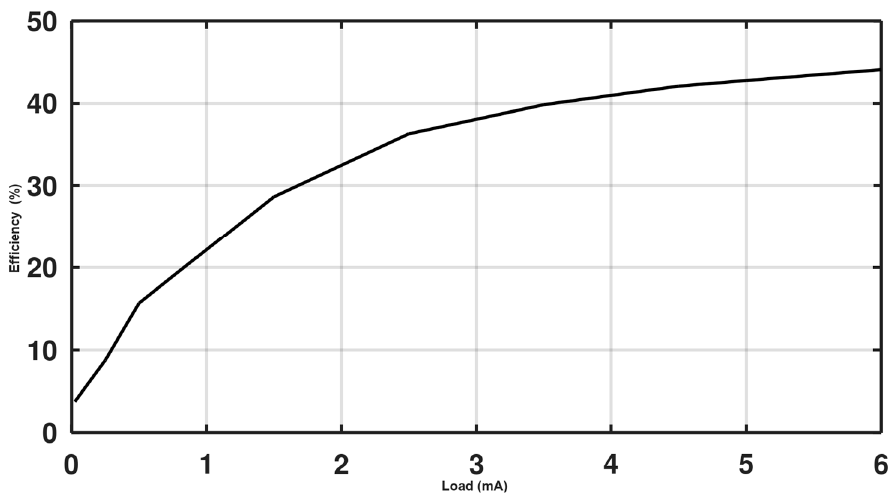
Figure 12. The efficiency of the converter vs. load.